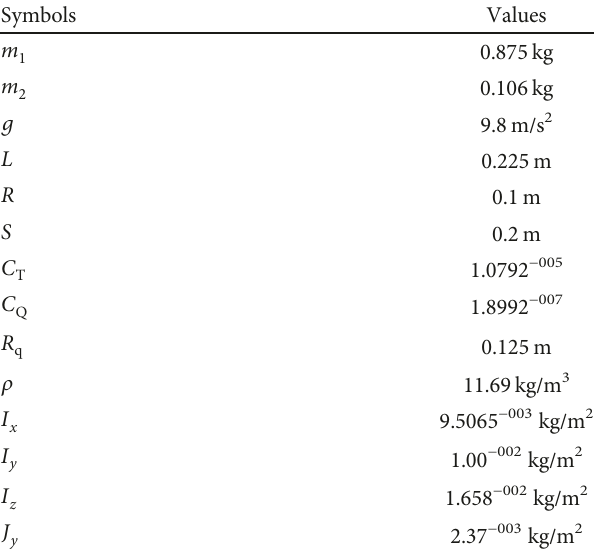
Table 1: MUAV parameters. Symbols